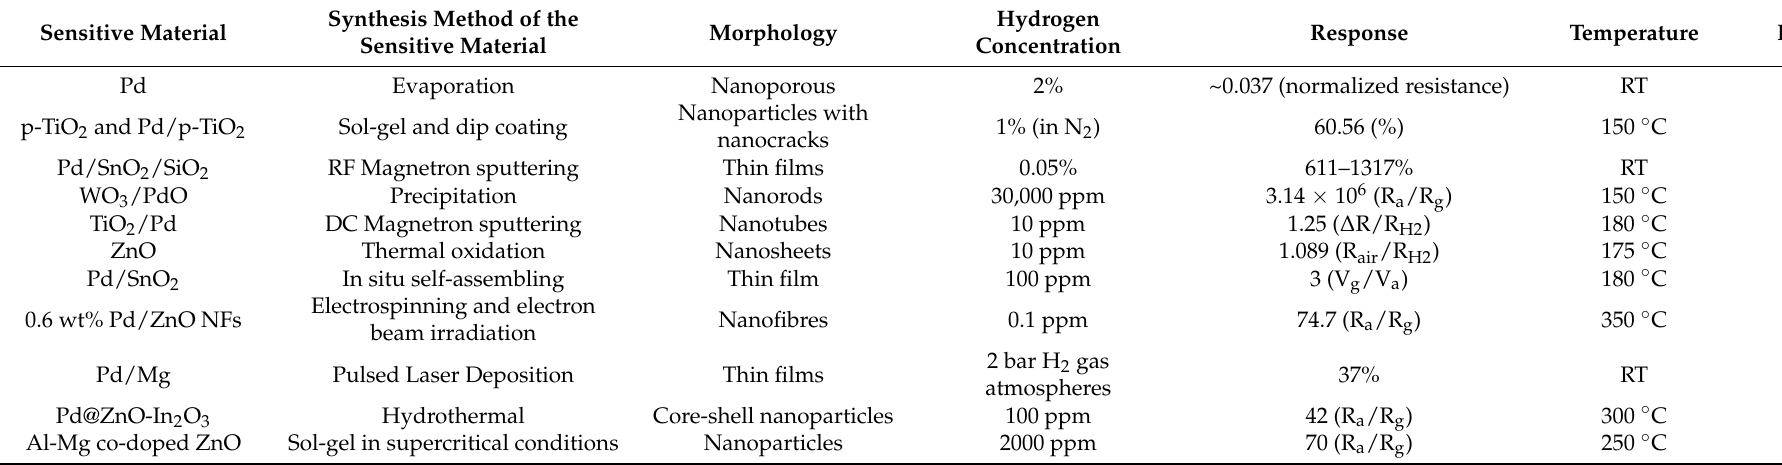
Table 1. Resistive sensors obtained by different synthesis